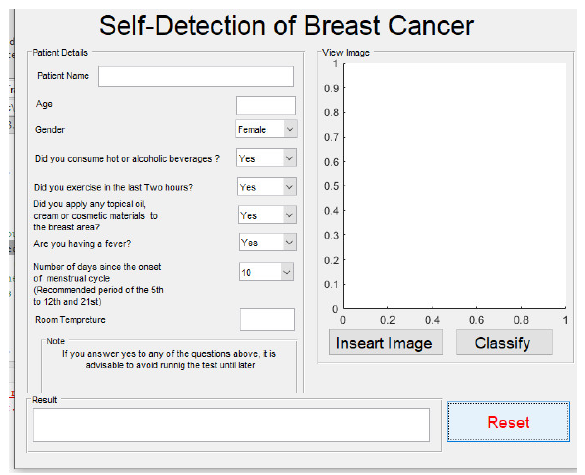
Figure 4. A GUIDE for breast cancer diagnosis from thermal images.